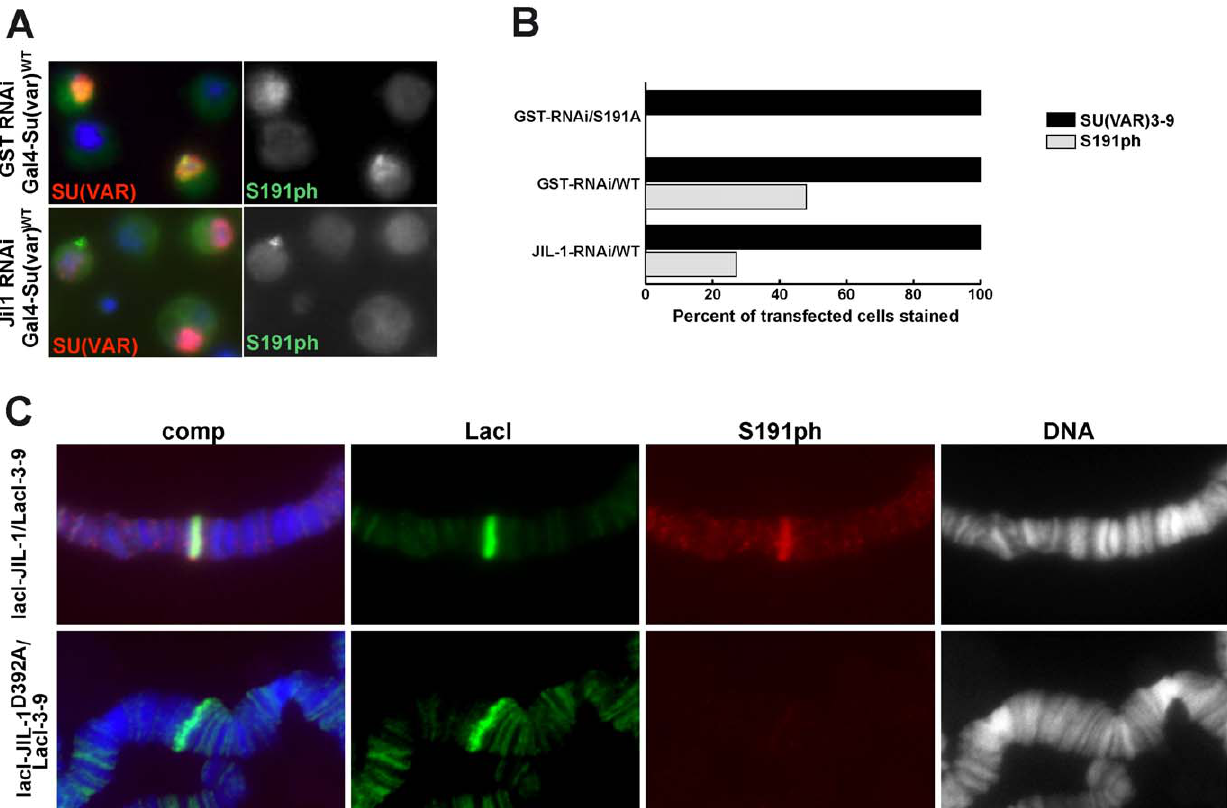
Figure 5. SU(VAR)3–9 is phosphorylated by JIL-1 invivo . ( A ) SL2 cells were subjected to either control RNAi (GST) or JIL-1 RNAi and transfected with Gal4-SU(VAR)3–9wt or Gal4-SU(VAR)S191A. Monoclonal antibodies specific for SU(VAR)3–9 detect the protein only in the transfected cells. S191ph signal is associated with the overexpressed Gal4-SU(VAR)3–9 in the control GST RNAi but not after JIL-1 RNAi. ( B ) Quantification of 2 independent experiments showed that no S191ph signal is associated with Gal4-SU(VAR)S191A overexpressing cells (n=192). 48% of the cells expressing Gal4-SU(VAR)wt have a S191ph signal in GST control RNAi (n=303), and only 27% after JIL-1 RNAi (n=311). ( C ) Phosphorylation of SU(VAR)3–9 by co-tethering of lacI-SU(VAR)3–9 and lacI-JIL-1 fusion proteins. The panels represent triple labelings of polytene squash preparations from third instar larvae homozygous for the lacO repeat line P11.3. LacI-SU(VAR)3–9 and LacI-JIL-1 were tethered to the lacO repeats in the upper panel and LacI-SU(VAR)3–9 with a catalytically inactive LacI-JIL-1 in the lower panel. LacI antibody labeling is shown in green, 3–9ph antibody labeling in red, and Hoechst labeling of DNA in blue or grey. The white arrows indicate the lacO repeat insertion site. Top : At the lacO repeat insertion site where LacI-SU(VAR)3–9 and LacI-JIL-1 are co-tethered there is robust phosphorylation of LacI-SU(VAR)3–9 as detected by the S191ph antibody. Bottom : In contrast, when LacI-SU(VAR)3–9 is co-tethered with an inactive LacI-JIL-1 construct there is no or little phosphorylation of LacI-SU(VAR)3–9 detectable by the S191ph antibody. Note: In additon to the lacO tethering site the LacI constructs also localize to their endogenous chromatin binding sites as shown by the localization of LacI-JIL-1 to interband regions.